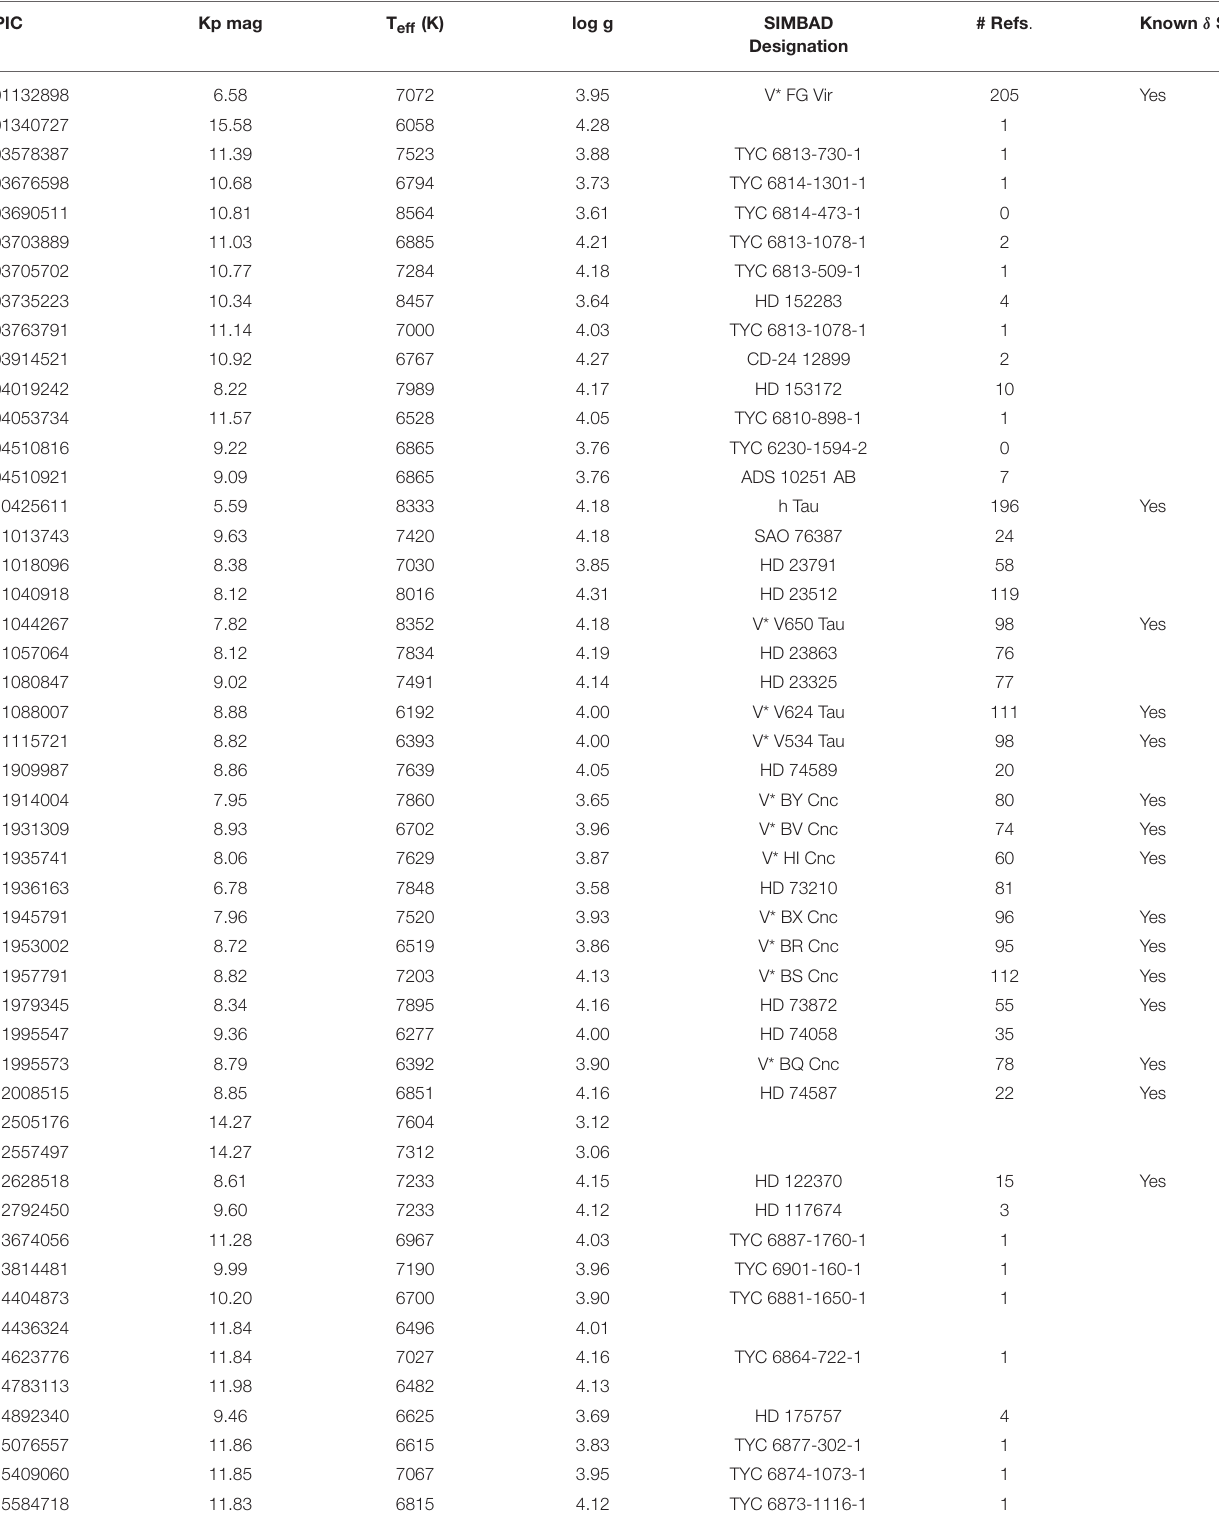
TABLE 2 | Summary of properties of δ Sct